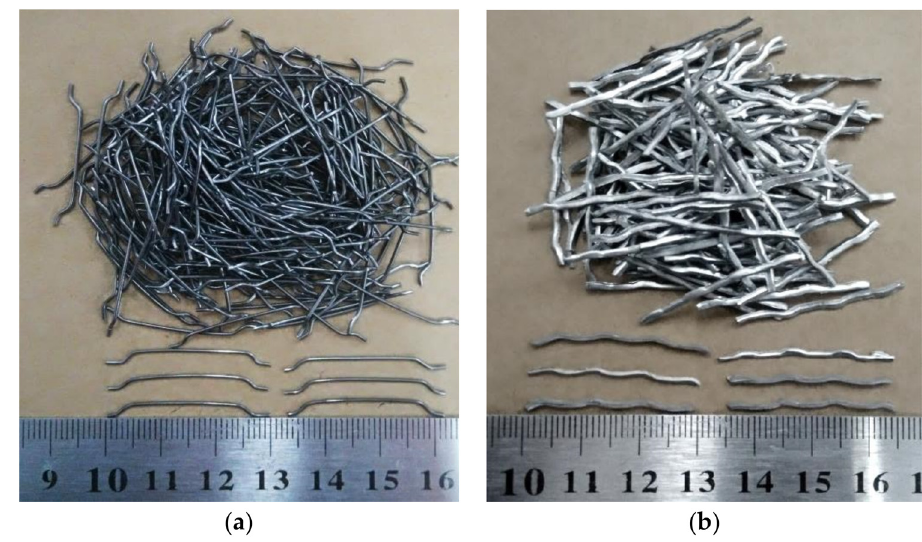
Figure 3. ( a ) Hooked-end steel fiber; ( b ) Crimped steel fiber.